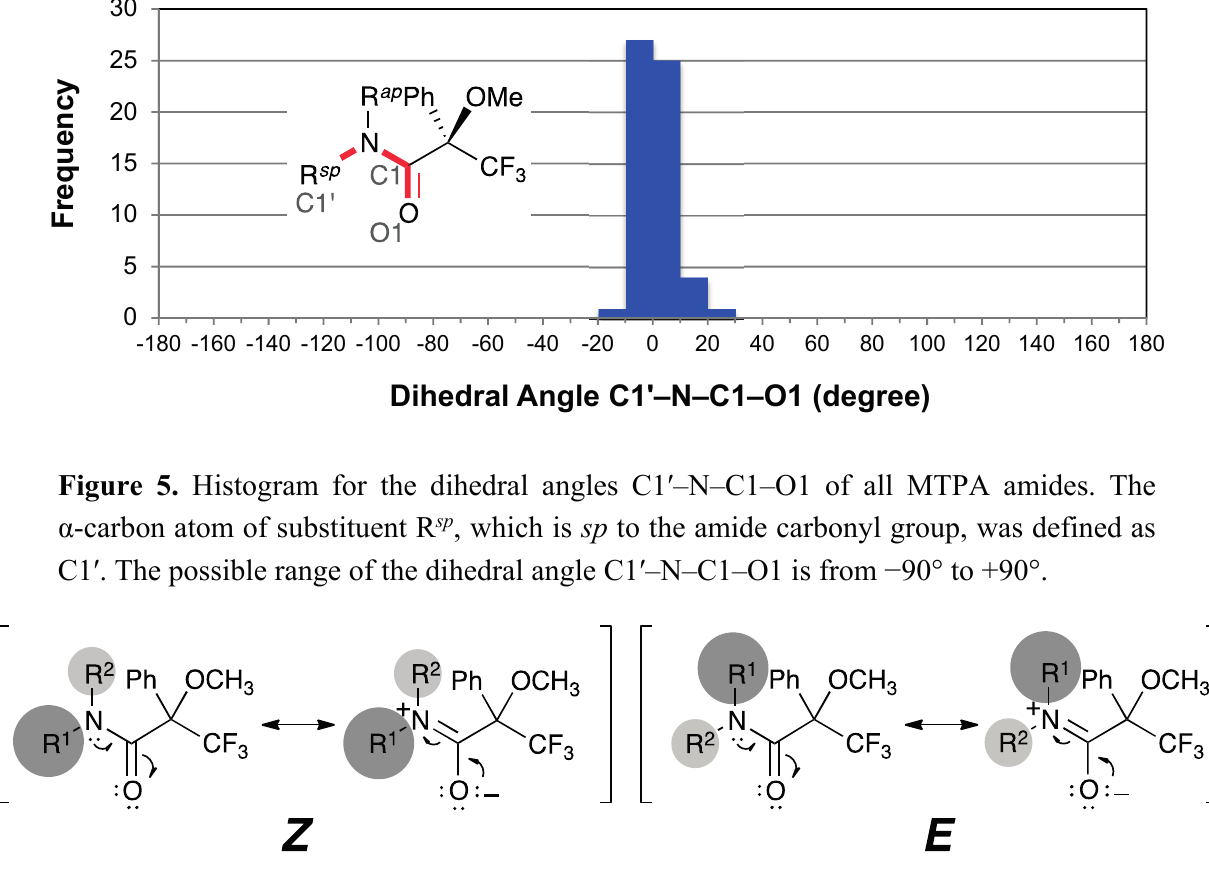
Figure 6. Z / E forms and their resonance hybrids of MTPA amides. R 1 indicates the substituents with higher Cahn–Ingold–Prelog (CIP) priority (e.g., secondary alkyl group); R 2 indicates the substituents with lower CIP priority (e.g., hydrogen atom and methyl